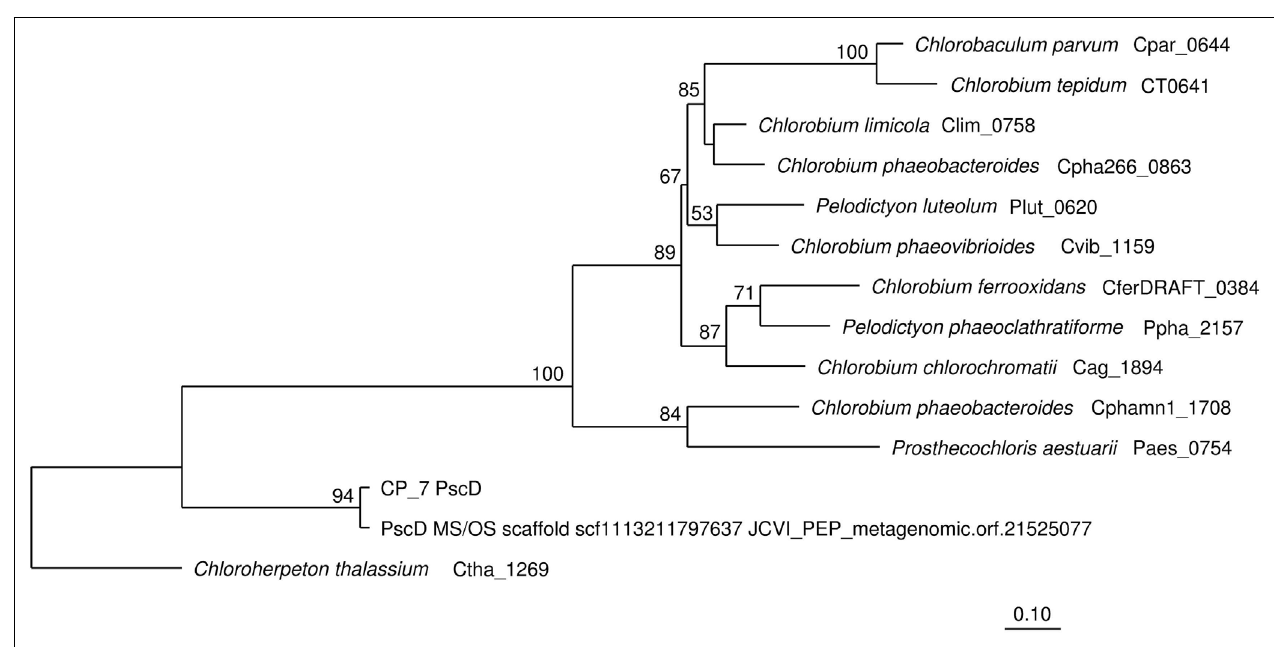
positions, with amino acid comparisons corrected using the Jones-Taylor-Thornton model (Jones et al., 1992). Bootstrap support for ≥ 50% of 1000 replicate trees are shown at nodes.